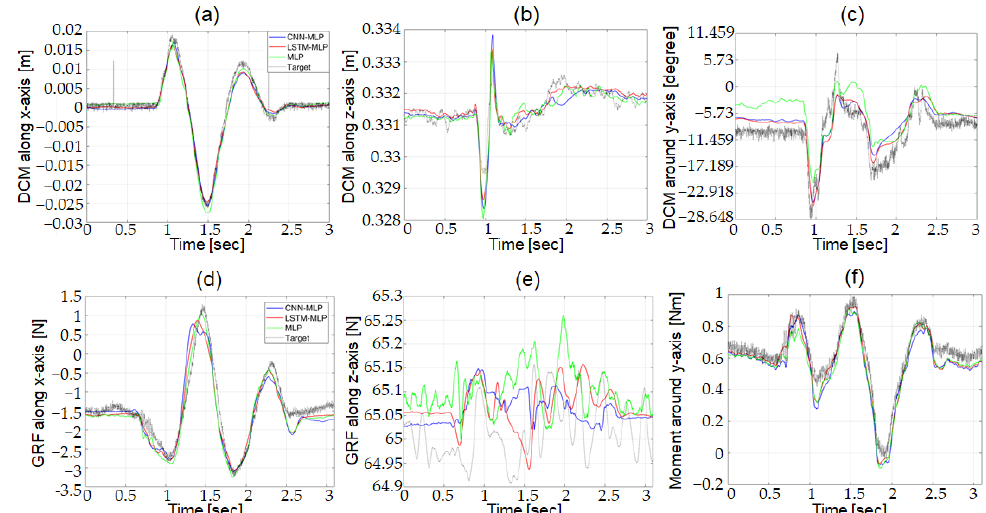
Figure 9. Comparison of target output and predictions from three optimized DNN structures using test data in robot dynamic simulator; ( a ) DCM along x-axis, ( b ) DCM along z-axis, ( c ) DCM around y-axis, ( d ) GRF along x-axis, ( e ) GRF along z-axis, and ( f ) Moment around y-axis.